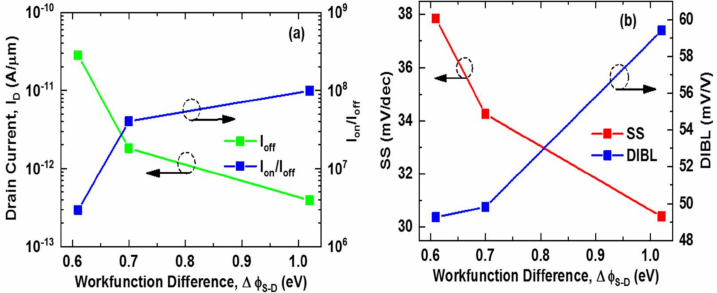
Figure 4. ( a ) I off and I on /I off and ( b ) SS and DIBL as a function of work function difference ( ∆ φ S-D ). The surface potential of the device in the off-state (V DD = − 0.5 V, V GS = 0 V) and on-state (V DD = V GS = − 0.5 V) is shown in Figure 5. The negative drain bias and gate bias reduce the surface potential in the drain and channel regions, respectively, while the surface potential in the grounded source region remains higher. However, in the channel region, the surface potential varies according to the work function difference ( ∆ φ S-D ). Hence, the highest and lowest surface potentials in the channel region, respectively, are caused by high work function difference ( ∆ φ S-D = 1.02 eV) and low work function difference ( ∆ φ S-D = 0.61 eV). The surface potential of single material gate devices remains constant through the channel region according to their work function. However, the surface potential of dual material gate devices introduces a step-like feature in the channel region according to their respective work functions [16,23].